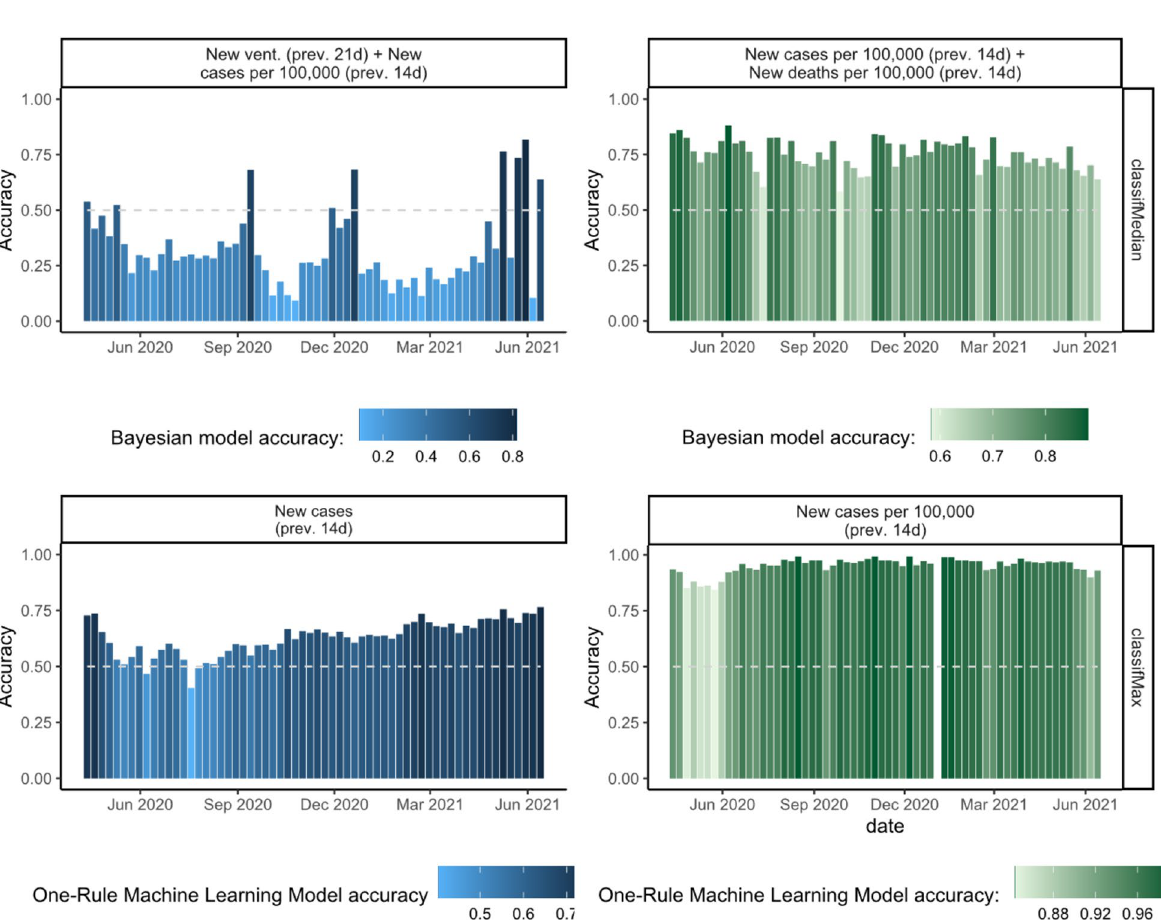
Figure 3. Predictive accuracies of best performing models by week. Each bar represents one week. The predictors for each model are detailed on the top of each graph. Left column: initial classification from March 2020. Right column: updated classification from November 2020. Top row: Proportional Bayesian Odds models. Bottom row: One-Rule Machine Learning